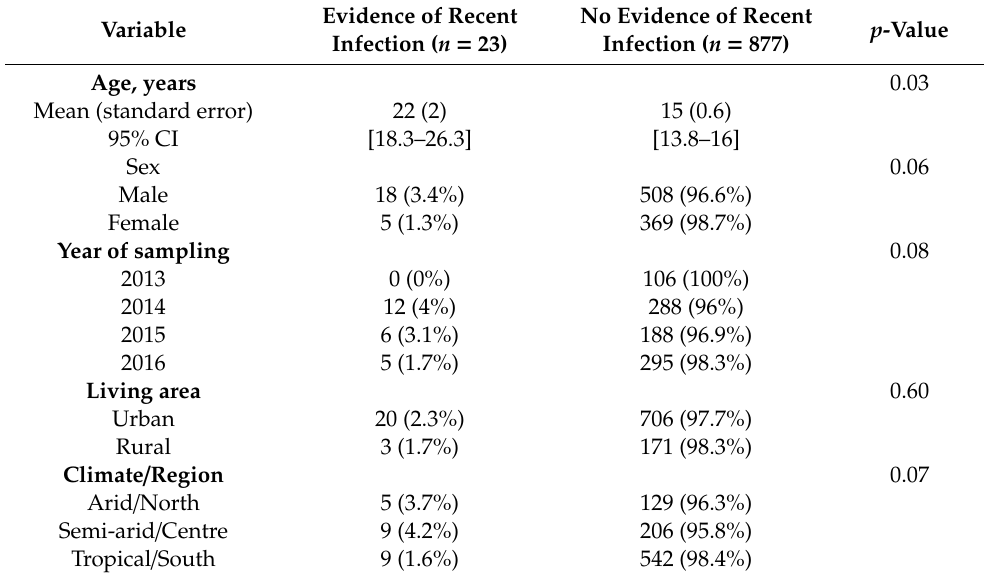
Table 1. Demographic characteristics of patients with markers of a recent HEV infection (anti-HEV IgM and / or HEV RNA positive).